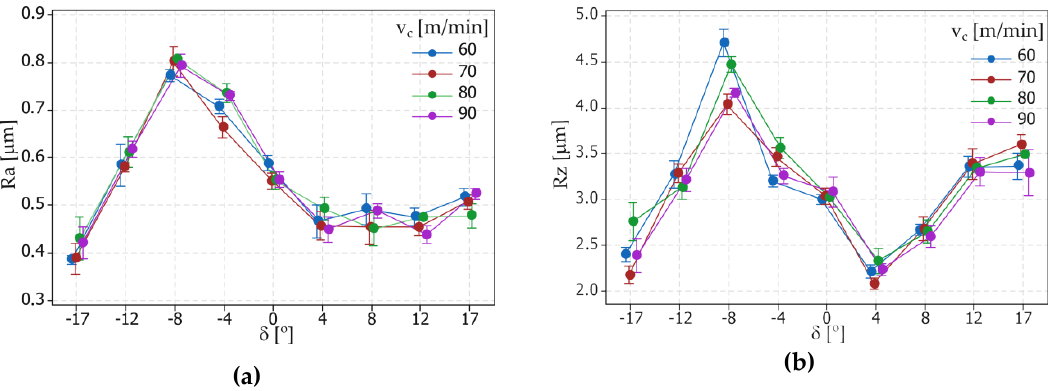
Figure 6. Graphs representing the relation between the tilted angle δ and surface roughness parameters: ( a ) Ra and ( b ) Rz; for different cutting speed v c values.